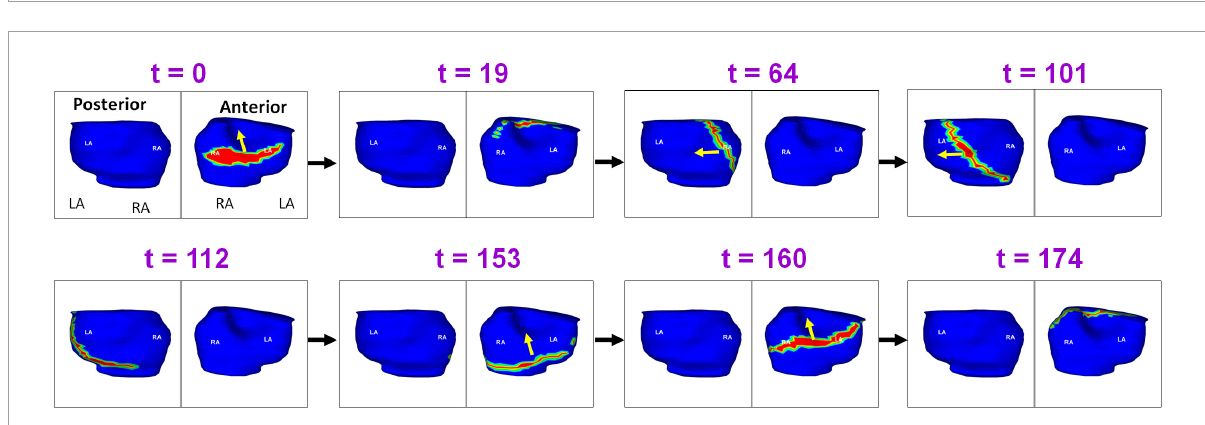
FIGURE3 Macro-reentry in persistent AF. Propagating wavefront is shown in red-green. Yellow arrow indicates its direction of propagation. Each rectangular box represents a time instance of bi-atrial activation shown in two views (posterior and anterior). Black arrows between the boxes indicate the chronological sequence of activation. The figure shows activity for 174 ms. LA, Left Atrium; RA, Right Atrium; t, time in milliseconds ( Supplementary Video 1